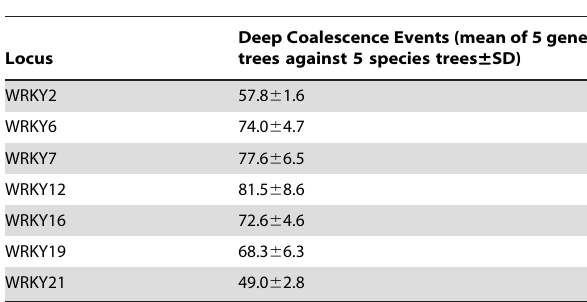
Figure 2. Majority rule consensus of 12,500 trees after burn-in sampled from mixed model (partitioned) Bayesian analysis of seven combined WRKY loci sequences aligned across Areceaceae tribe Cocoseae subtribe Attaleinae with MrBayes. Numbers above branches are posterior probability scores, i.e., the proportion of tree within which that clade was resolved. Letter in red at nodes are ancestral area optimizations as determined by dispersal-vicariance analysis: A=South Africa, B=Madagascar, C=Amazonas (north, east, south), D=Chile, E=Eastern Brazil, F=Central Brazil, G=Andes, H=Central America, I=Mexico, J=West Indies, K=Southern Brazil, L=Northern South America, i.e., Caribbean coastal Venezuela and Colombia, French Guiana, Guyana, Surinam, M=Argentina-Paraguay-Uruguay, N=Colombia-Venezuela ( llanos region), and O=western Amazonas. Ambiguous area optimizations at a node are separated by commas. doi:10.1371/journal.pone.0007353.g002 Table 4. Costs of reconciling each of seven WRKY loci gene trees (5 trees each) with a sample of equally parsimonious trees (5) found with the combined sequence matrix (‘‘species’’